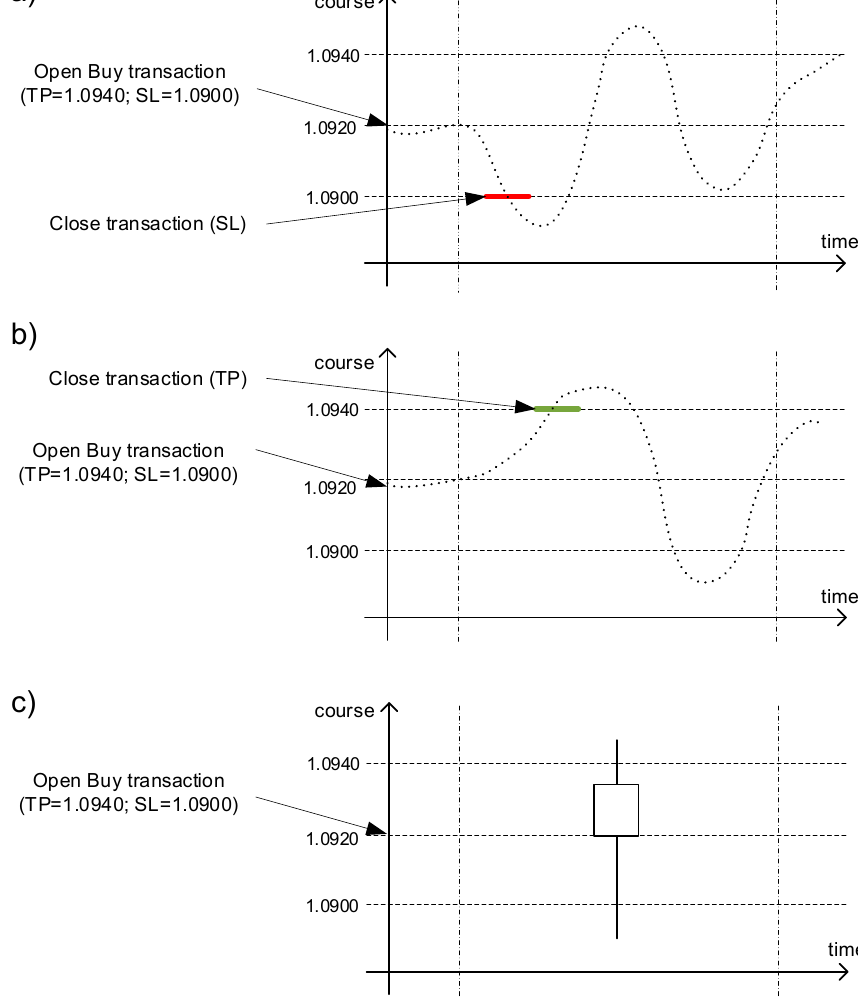
ff erent possible course trajectories ( a , b ) “inside” the same candle ( c Figure 4. Different possible course trajectories ( a , b ) “inside” the same candle ( c ). Figure 4. Di